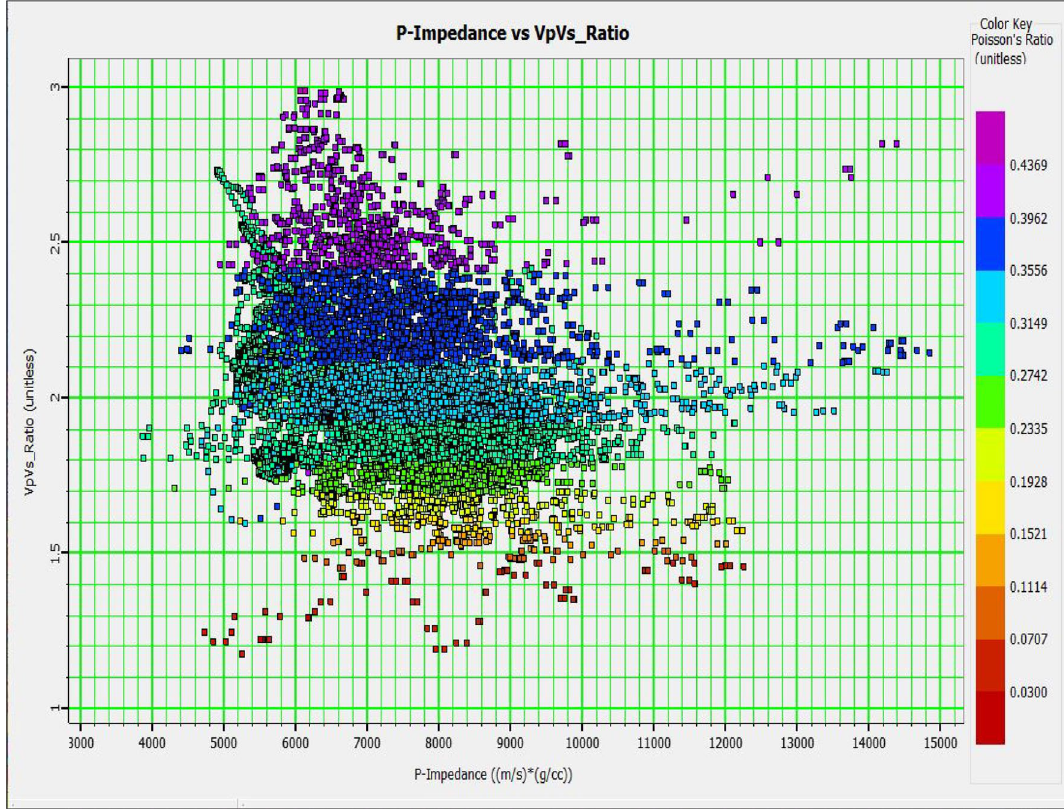
Figure 1. Cross plot of acoustic impedance (Z P ) and V P /V S